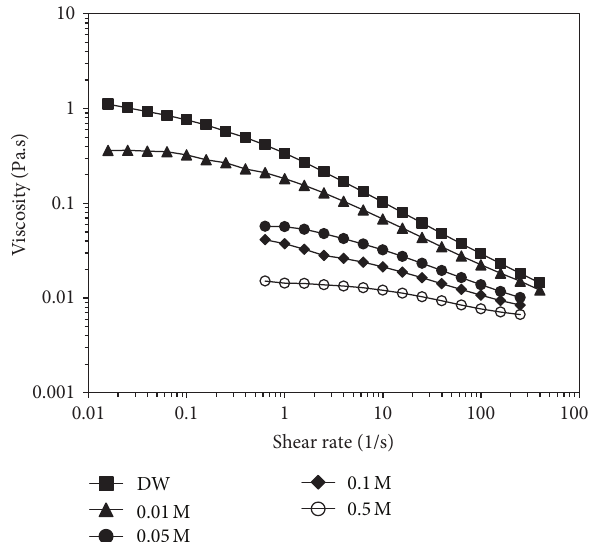
Figure 14: Effect of copolymer concentration on viscosity of SP solutions at different temperatures.